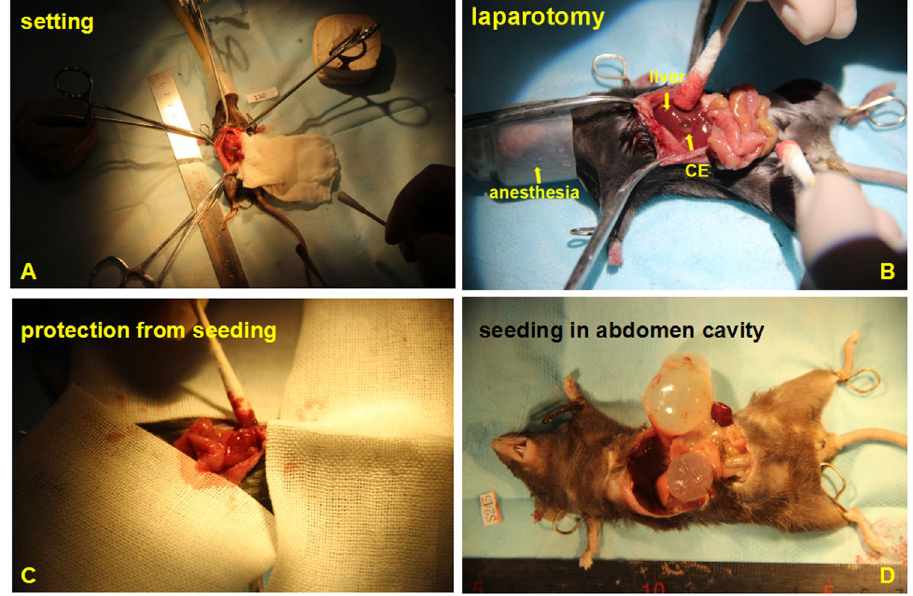
Figure 8. The standard therapeutic procedure surgery. (1) surgery setting; ( B ) the procedure; ( C ) special protection to prevent parasite planting; ( D )The post surgery complication of parasite seeding in the abdomen